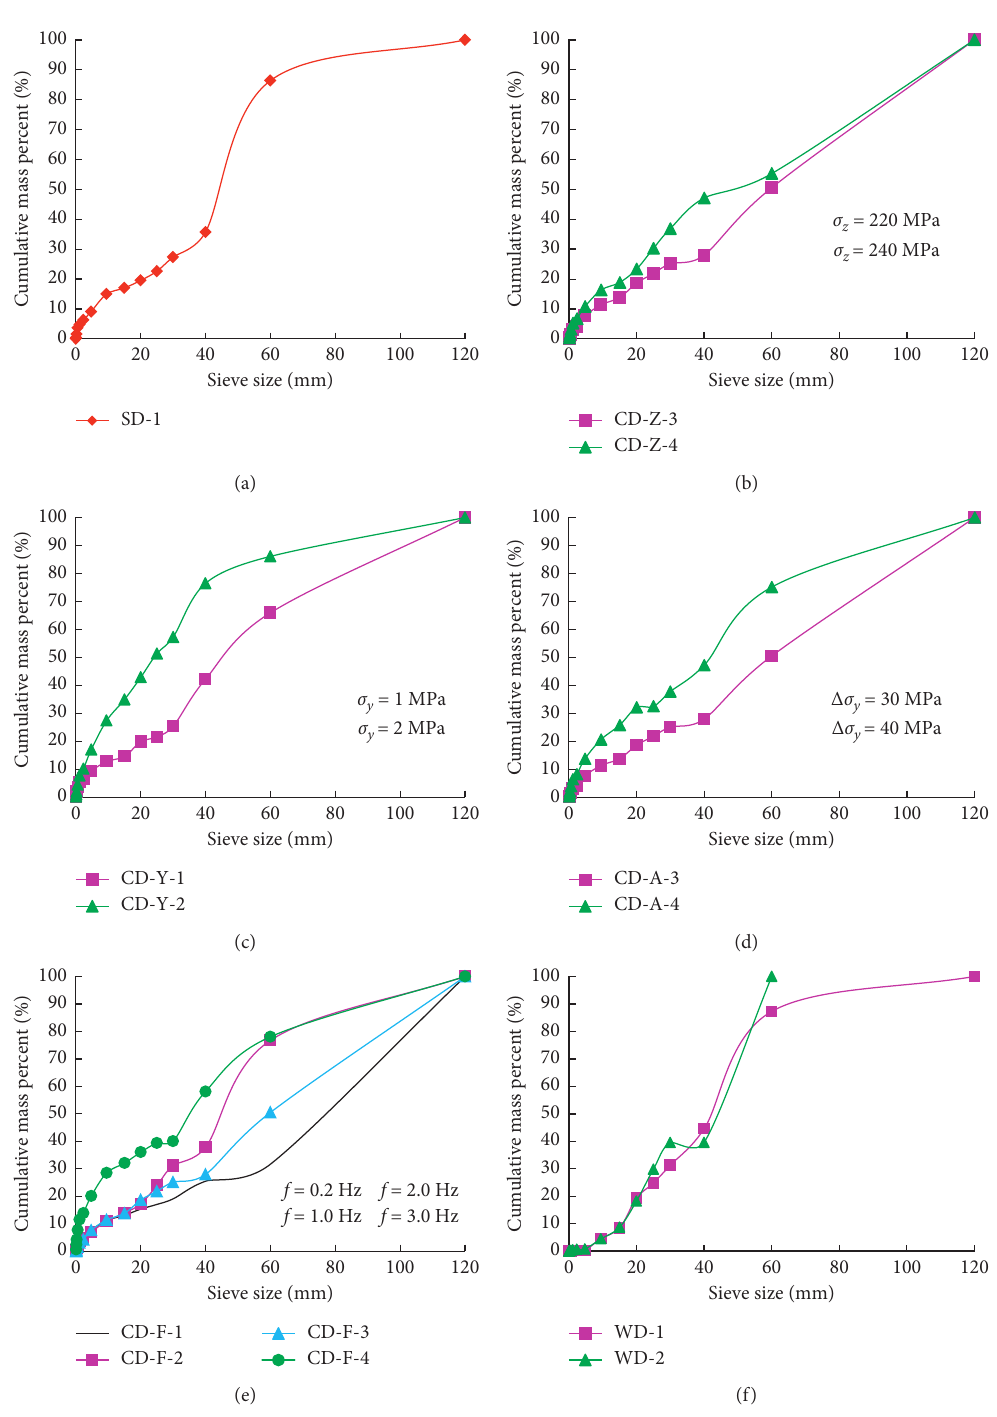
Figure 4: Cumulative mass distribution of fragments of different types of rockbursts: (a) the self-initiated rockbursts; (b–e) the moderate seismically induced rockbursts, (b) the maximum static stress σ z test group, (c) the minimum static stress σ y test group, (d) the disturbance amplitude Δ σ test group, and (e) the disturbance frequency f test group; and (f) the weak seismically induced